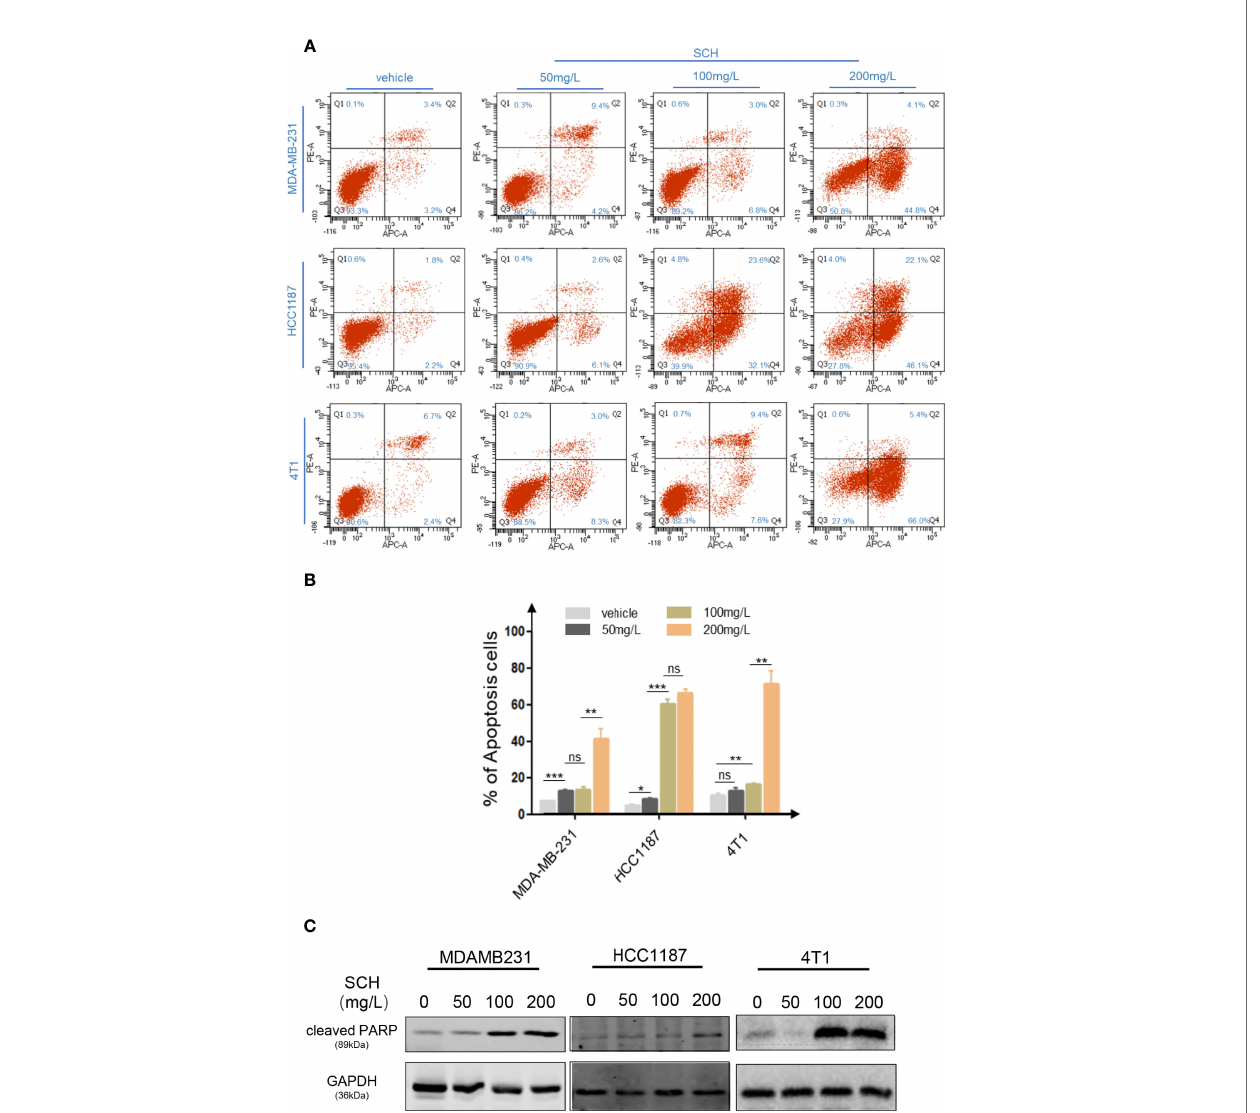
FIGURE 2 | SCH activates TNBC cell apoptosis. (A) Apoptotic cell death was evaluated via fl ow cytometric analysis subsequently DAPI and FITC-Annexin V staining in cells treated with varying dosages of SCH. (B) The % of Annexin V+/PI- (early apoptotic cells, lower right), Annexin V+/PI+ (late apoptotic cells, upper right), Annexin V-/PI- (viable cells, lower left), and Annexin V+/PI+ (necrotic cells, upper left) cells are displayed. Columns epitomize the % of Annexin V-positive TNBC cells. “ ns, ” not signi fi cant, *P < 0.05, **P < 0.01, ***P < 0.001 (Student ’ s t -test). (C) TNBC cells were treated with varying dosages of SCH for 24 h and then subjected to an immunoblotting analysis.